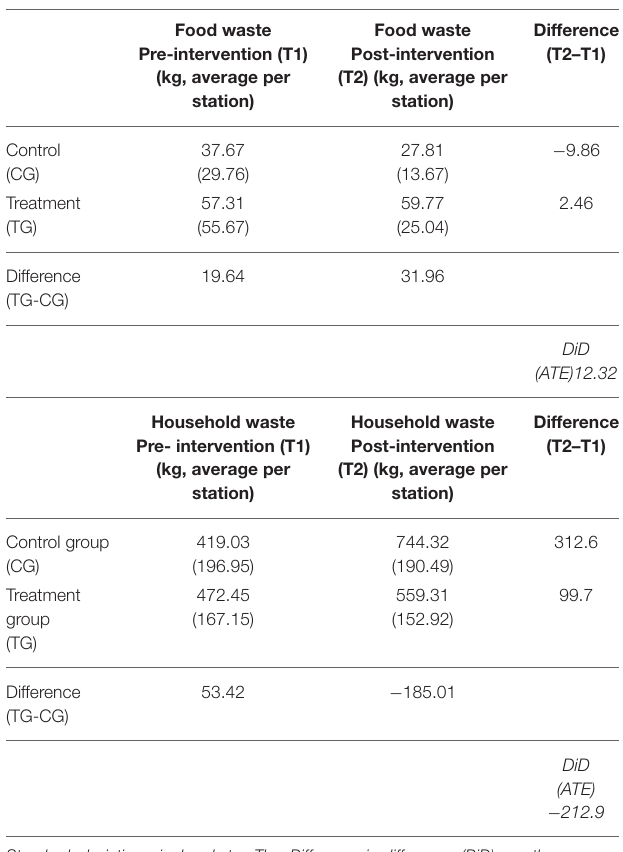
TABLE 2 | Average amount of food waste and household waste collected per sorting station in the control group (five stations) and in the treatment group (four stations) before and after implementation and the difference between the groups before and after implementation.